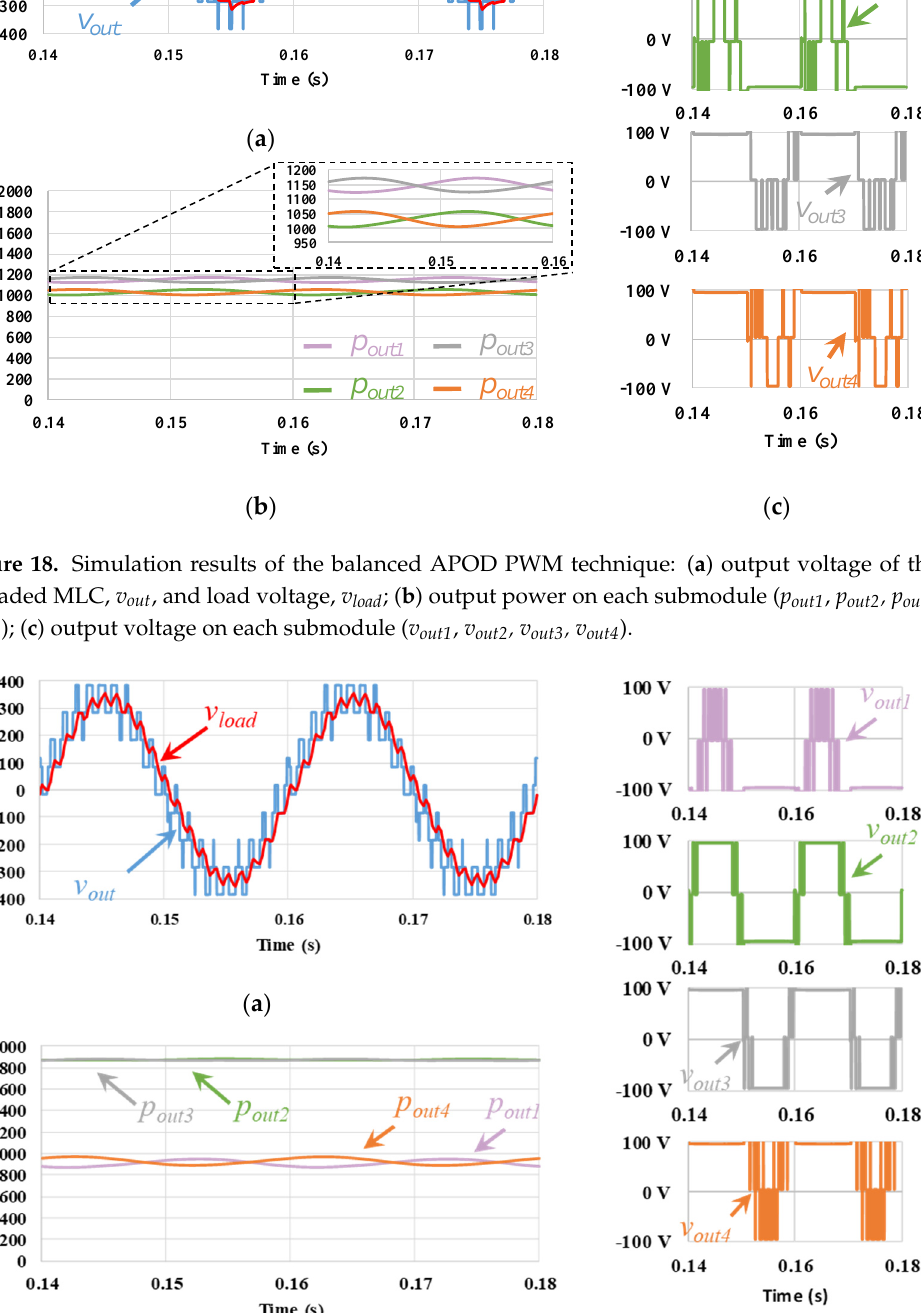
Figure 19. Simulation results of the CO PWM technique: ( a ) output voltage of the cascaded MLC, v out , and load voltage, v load ; ( b ) output power on each submodule ( p out1 , p out2 , p out3 , p out4 ); ( c ) output voltage on each submodule ( v out1 , v out2 , v out3 , v out4 ).